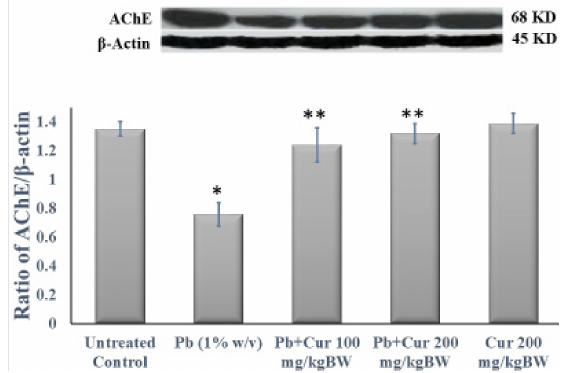
Figure 3. Effect of curcumin on the expression of acetylcholinesterase (AChE) in Pb-treated mouse brain. The internal control of protein bands was examined using β -actin in a relative density analysis.